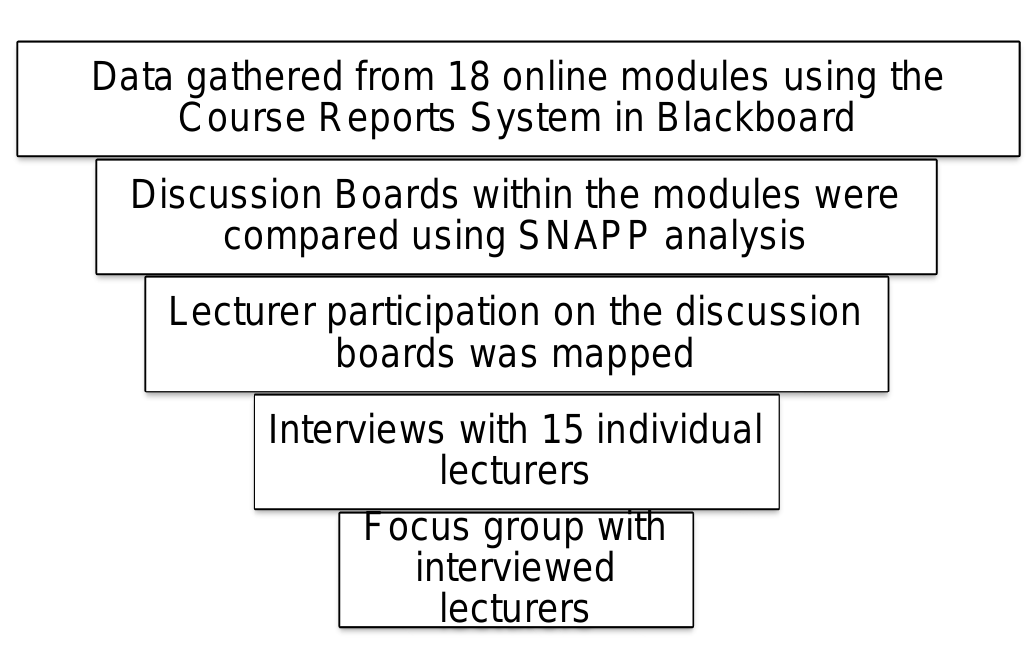
Figure 1. Layers of data collection for research